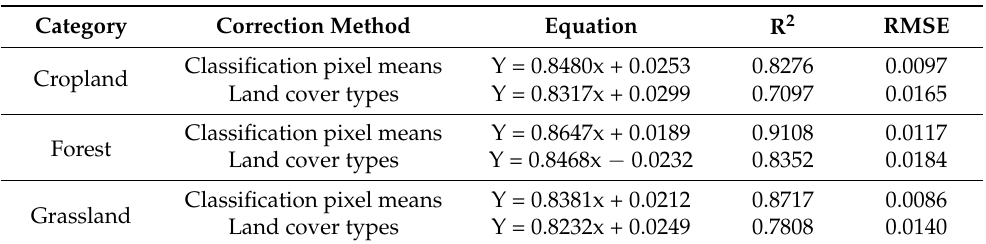
Figure 12. Comparison of apparent reflectance scatter points for land cover types correction and classification pixel means correction. ( a ) Classification pixel means correction; ( b ) land cover types correction. N is the number of image pixels, the black dashed line is the 1:1 line, and the red solid line is the regression line of the scatter plot. Table 6. Statistical comparison between classification pixel means correction and land cover types correction based on the images from different